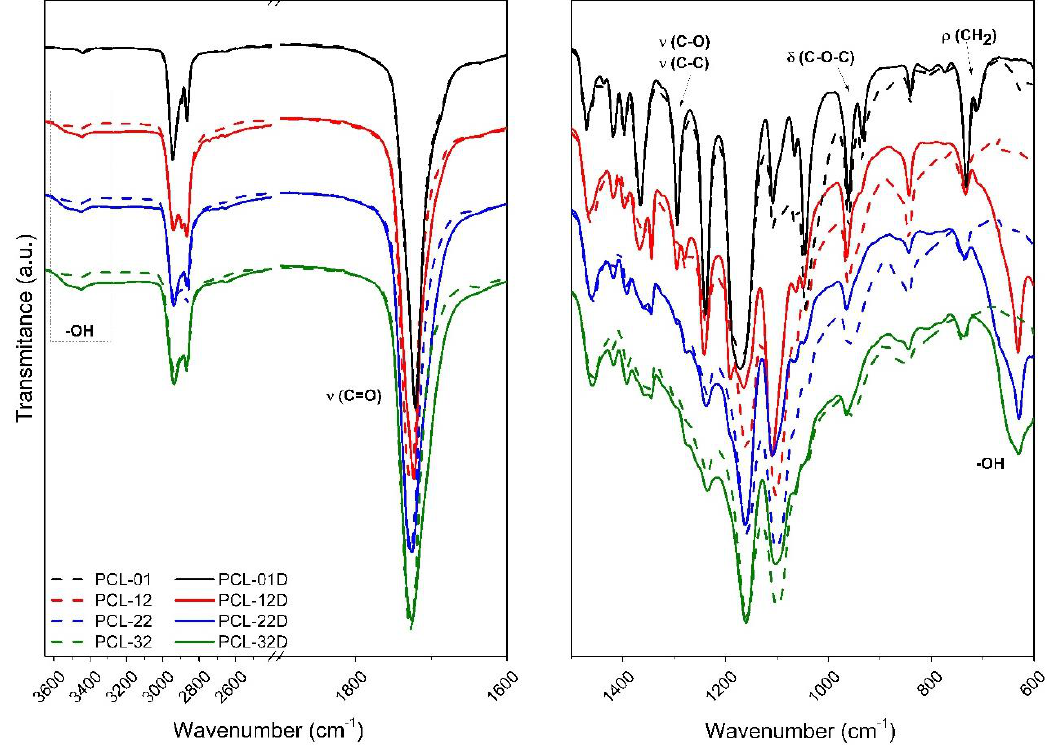
Figure 3. Fourier transform infrared spectroscopy (FTIR) spectra of PCL-12, PCL-22, PCL-32 and the non-crosslinked PCL-01 before and after hydrolytic degradation (denoted with a D) for 70 days at 60°C.